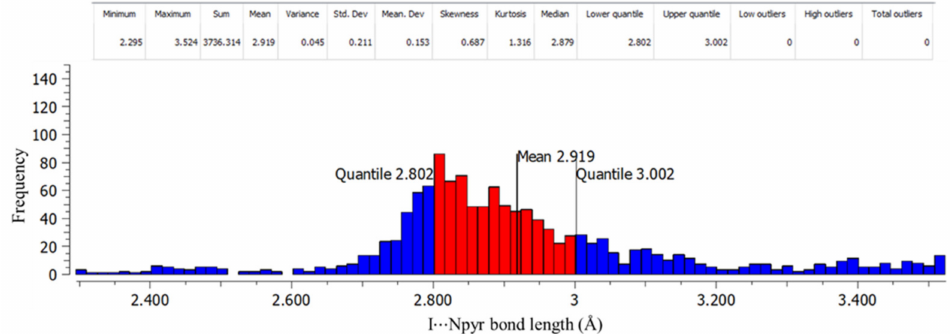
Figure 8. Histogram showing bond length against frequency for I · · · Npyr halogen